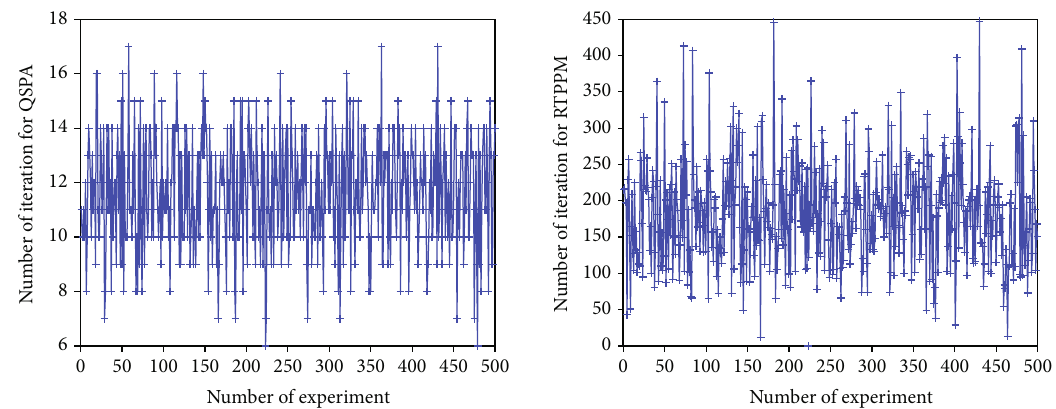
Figure 1: The iteration number of QSPA and RTPPM.